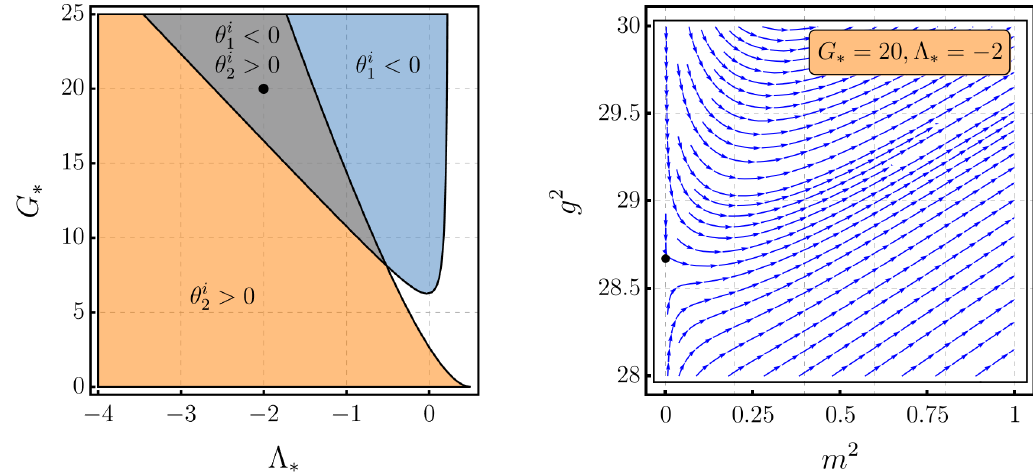
Figure 4 . On the left, in blue, we highlight the parameter space where there are solutions for interacting-fixed points in the presence of gravity. At the same region, θ i region where θ i > 0 . On the right, we show a stream plot around the interacting fixed-point, 2 for G = 20 , Λ = − 2 . The black dot indicates the location of the interacting fixed-point. The ∗ ∗ arrows and lines represent the flow from UV to IR, showing that the m 2 direction is relevant and g 2 is